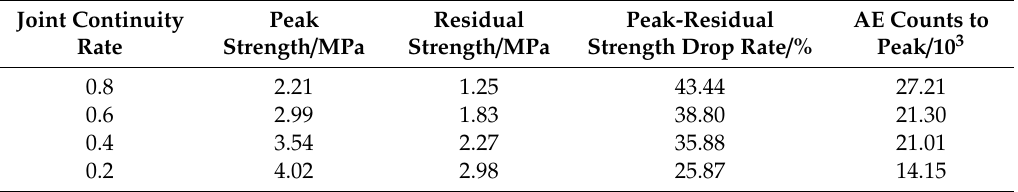
Table 2. Relationship between the peak-residual strength drop rate and AE counts in scheme I.